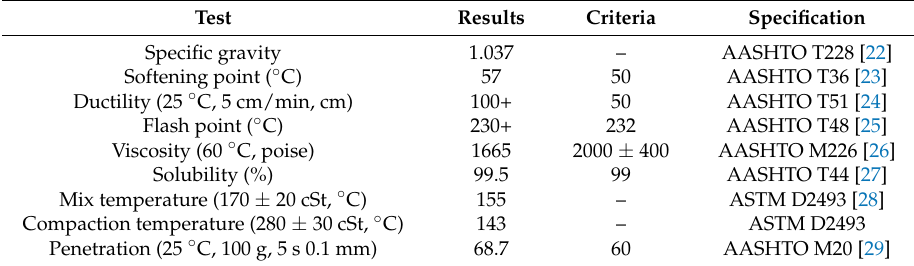
Table 2. The asphalt binder